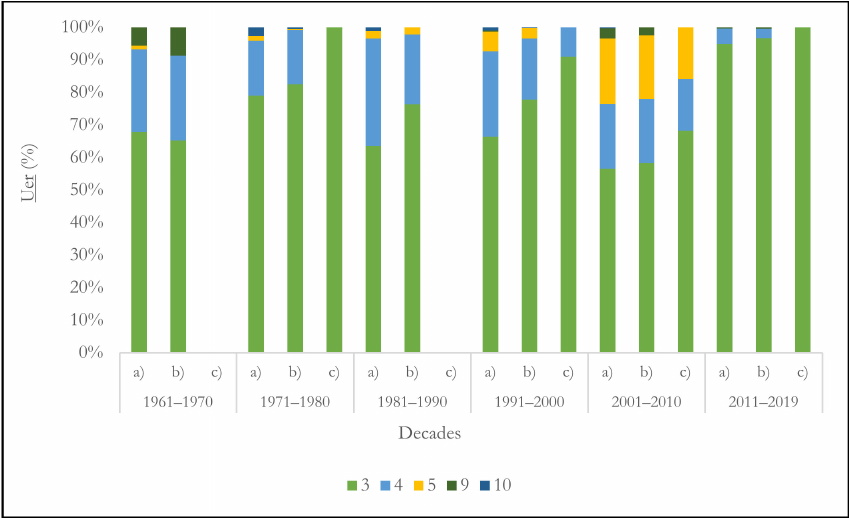
Figure 8. Frequency of Uer occurrence in selected months across decades for scenarios a, b, and